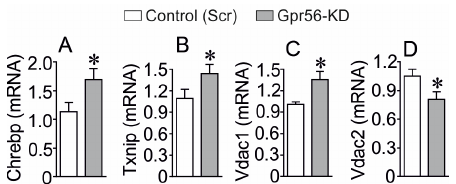
Figure 2. Effect of GPR56-KD on the expression of Chrebp, Txnip, Vdac1, and Vdac2 mRNA expression in INS-1 832/13 cells. GPR56-KD increased expression of Chrebp ( A ), Txnip ( B ), Vdac1 ( C ), and reduced Vdac2 ( D ), mRNA as measured by qPCR in INS-1 832/13 cells. Mean ± SEM from four different experiments in each group are shown. * p < 0.05.